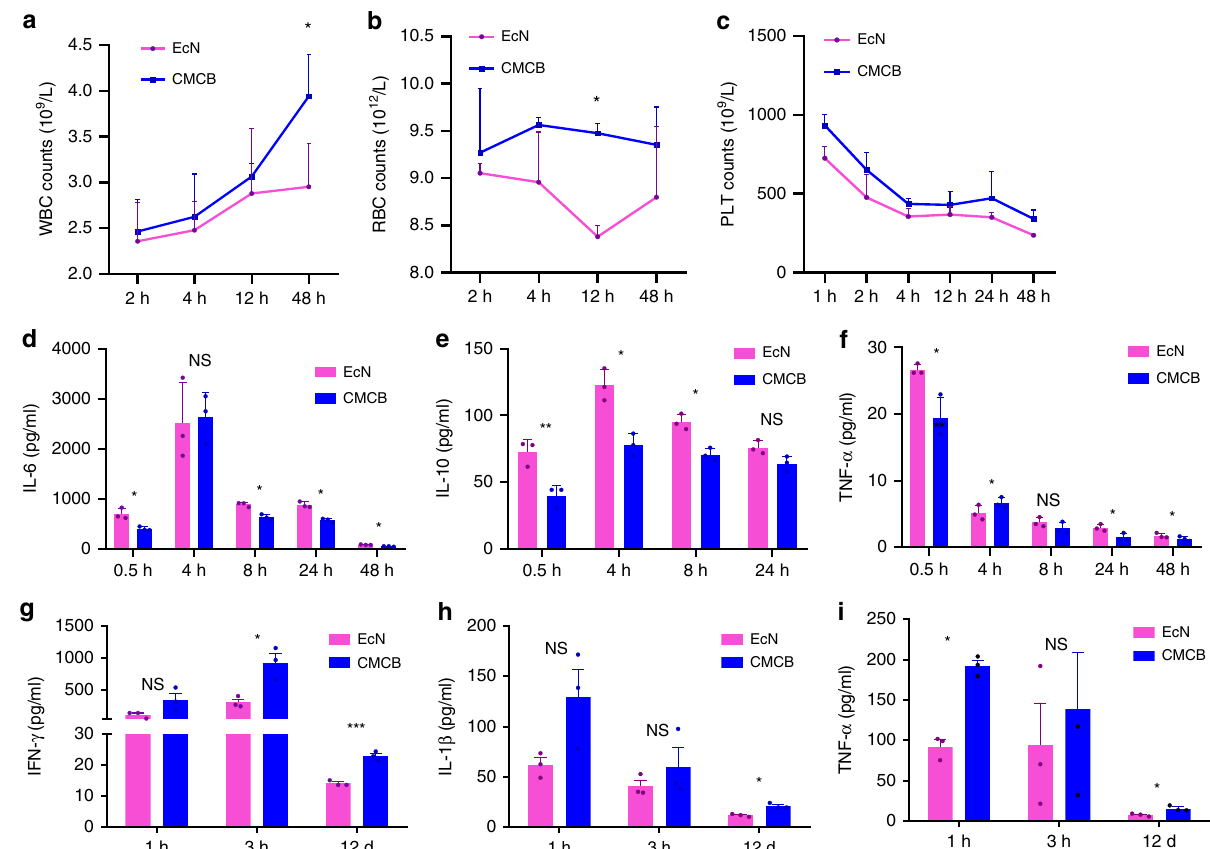
Fig. 3 Assessment of in vivo in fl ammatory response. a – f EcN or CMCB (1 × 10 7 CFUs) were injected through the tail vein and blood was withdrawn intraorbitally at the indicated time points. a – c Routine blood analysis including WBC, RBC and PLT counts. d – f Levels of cytokines in serum measured by commercially available ELISA kits, including IL-6, IL-10, and TNF- α . g – i Measurement of cytokines including g IFN- γ , h IL-1 β , and i TNF- α in 4T1 tumor- bearing mice. Each mouse was treated with EcN or CMCB (1 × 10 7 CFUs) through the tail vein and blood was withdrawn intraorbitally at the indicated time points. Error bars represent the standard deviation ( n = 3). Signi fi cance was assessed using Student ’ s t -test, giving p values, * p < 0.05, ** p < 0.01, *** p < 0.005. NS no signi fi